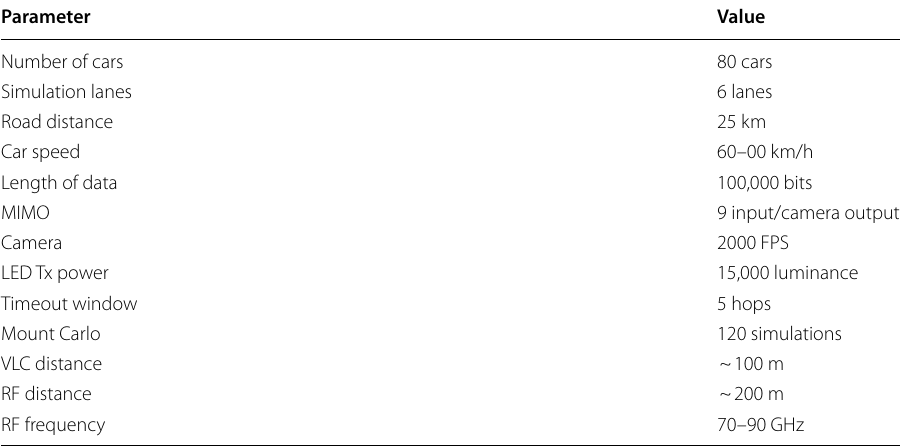
Table 1 MATLAB model simulation